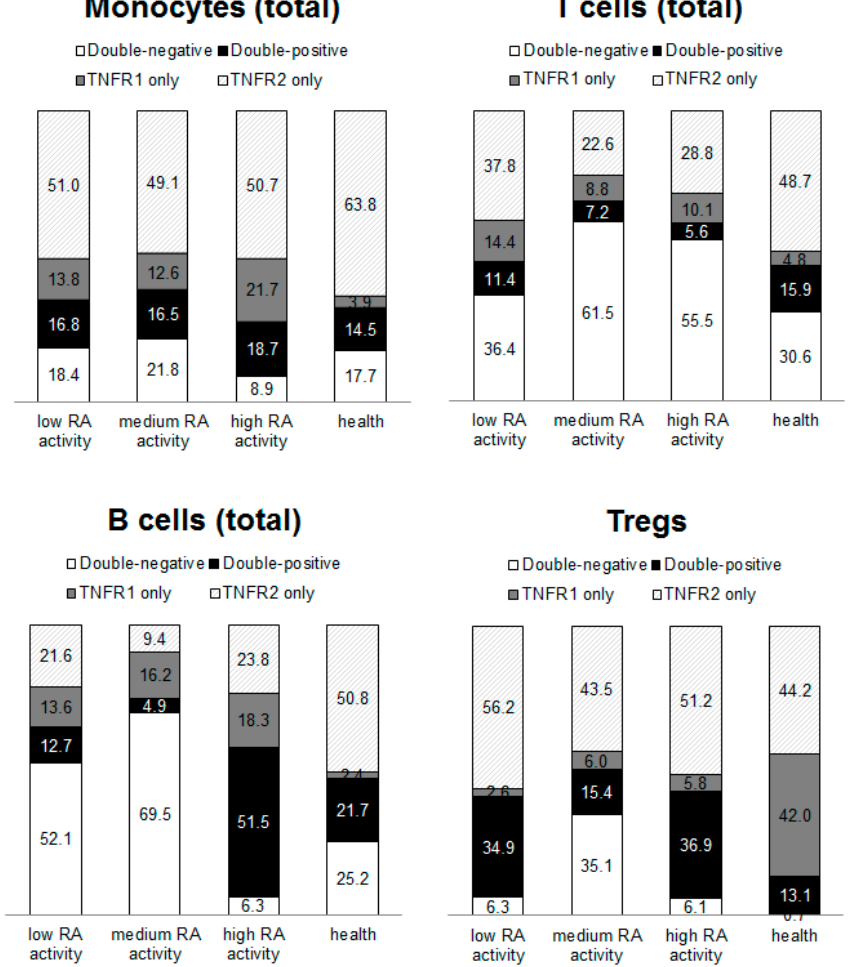
Figure 1. Co-expression profiles for TNF receptors in main subpopulations of MNC PC of healthy donors and patients with RA.